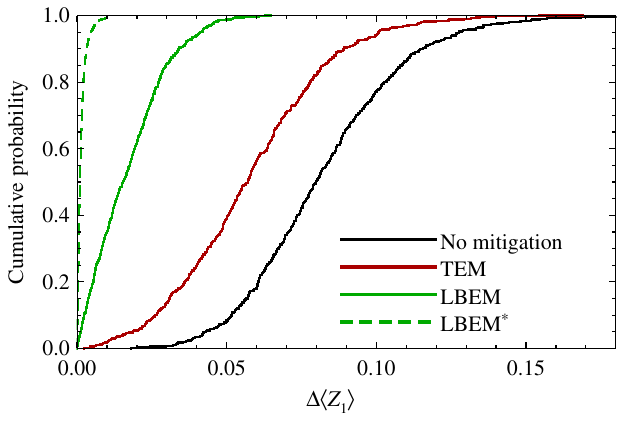
FIG. 3. Empirical cumulative distribution function of esti- mated (cid:7) (cid:10) Z 1 (cid:2) for 500 pseudorandom circuits with temporally correlated dephasing noise. Results for circuits without error mit- igation (black), with tomographic error mitigation (red), and with learning-based error mitigation (green) are presented. Addition- ally, we include the results for learning-based error mitigation when the sample size M → ∞ (dashed